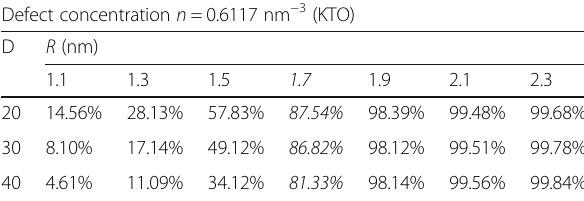
Table 3 Number of defects in the infinite cluster for different distances R and values D